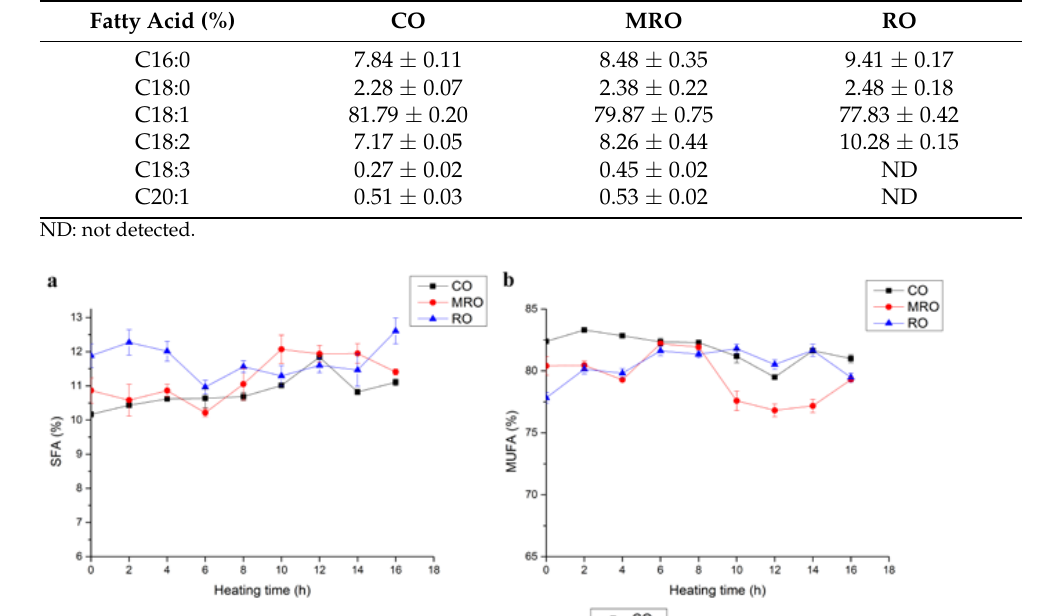
Table 1. The initial fatty acid composition of three kinds of camellia oil. Fatty Acid (%)